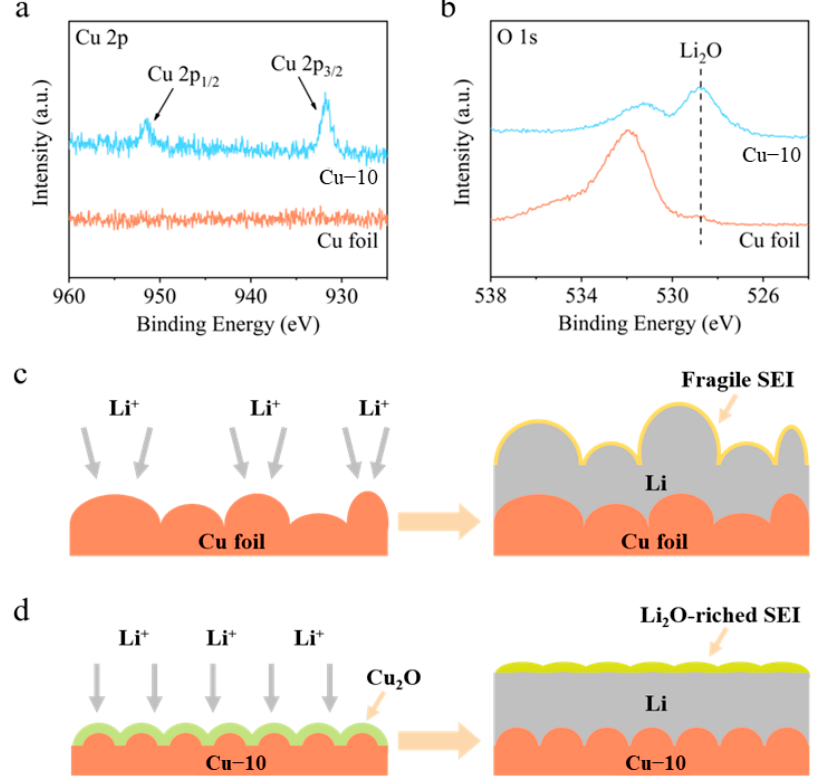
Figure 4. ( a ) Cu 2p and ( b ) O 1s XPS spectra of the surface of the commercial Cu foil and Cu − 10